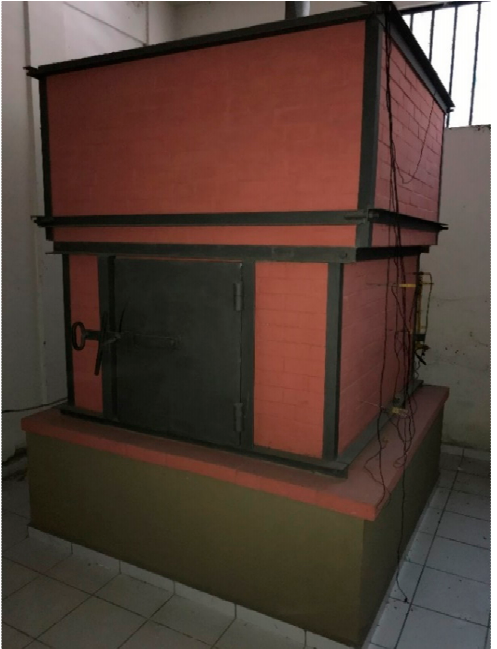
Figure 1. Intermittent ceramic kiln used in the study.